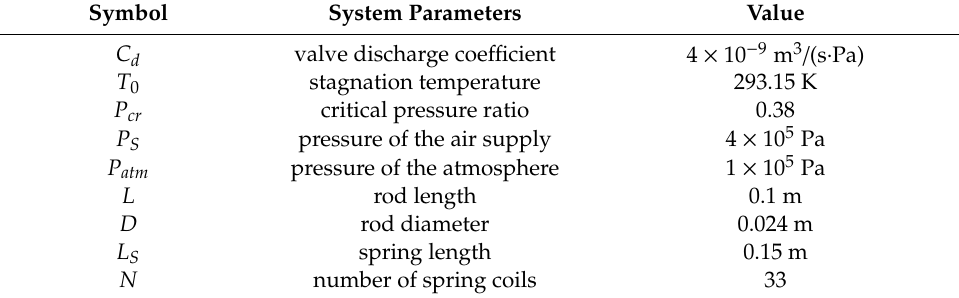
Table 5. System parameters.